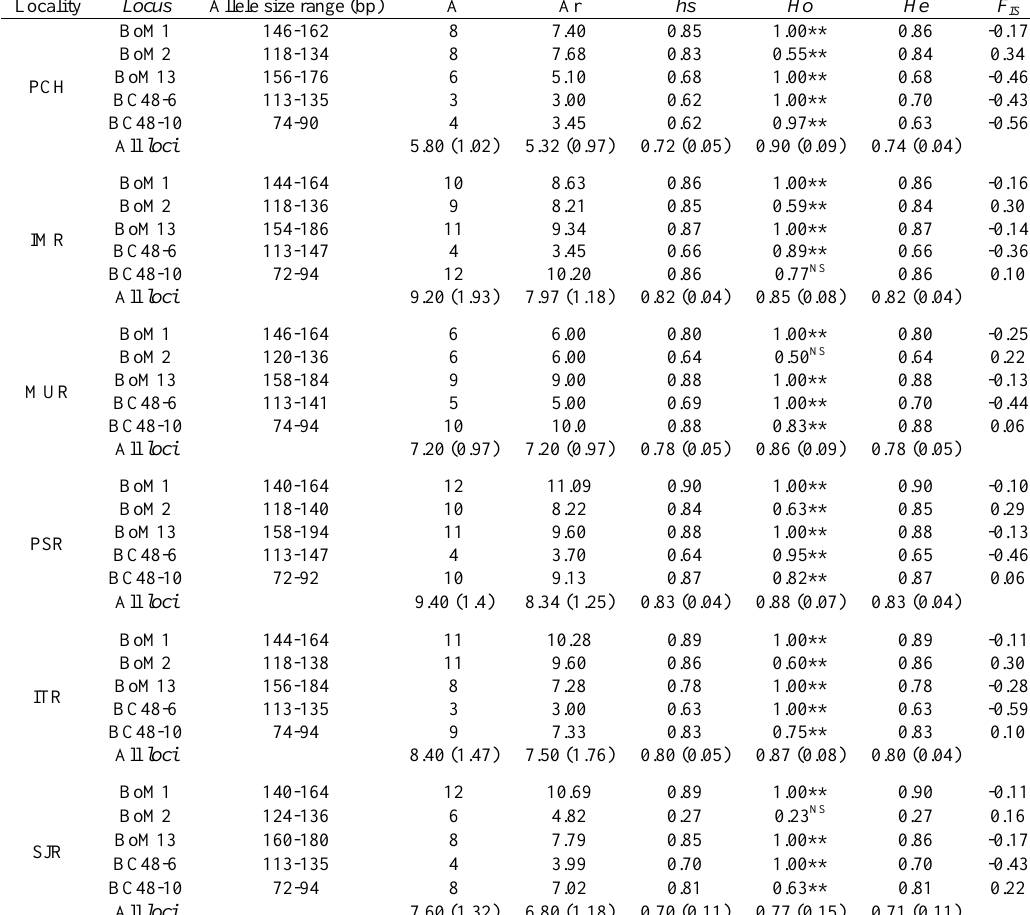
Table 3. Summary statistic for genetic diversity at five microsatellite loci of Brycon insignis in six sampling sites: number of alleles ); Nei’s genetic diversity (hs), observed ( H (A), allelic richness (A R ( F ). NS - Not significant and **- Highly significant ( p < 0.01) after Bonferroni adjustment (nominal α = 0.05). Power Company IS Hatchery (PCH), São João River (SJR), Paraíba do Sul River (PSR), Imbé River (IMR), Muriaé River (MUR) and Itabapoana River